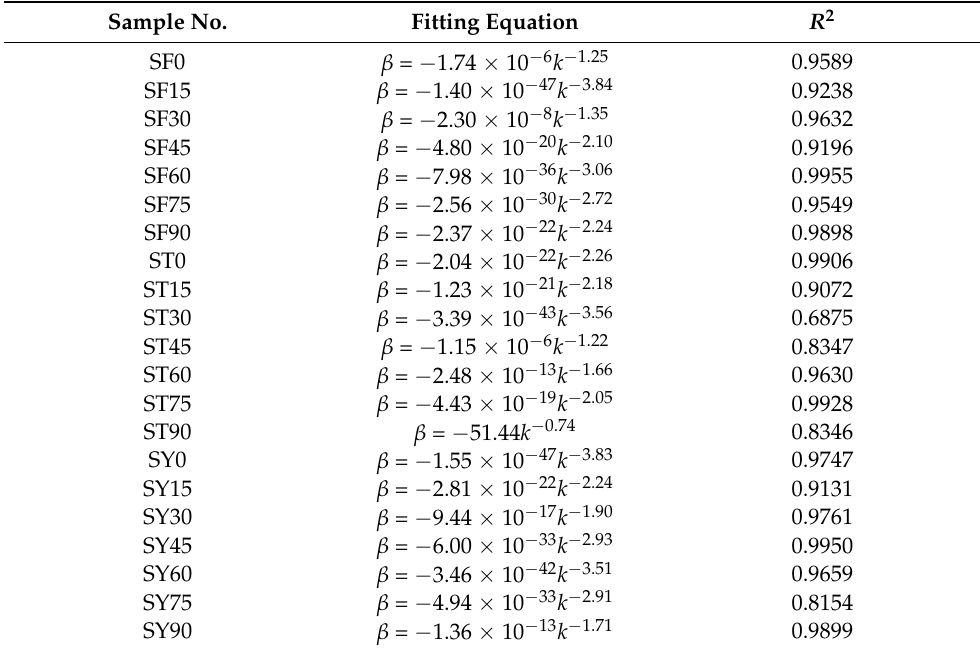
Table 2. Fitting values of nonlinear seepage coefficients of